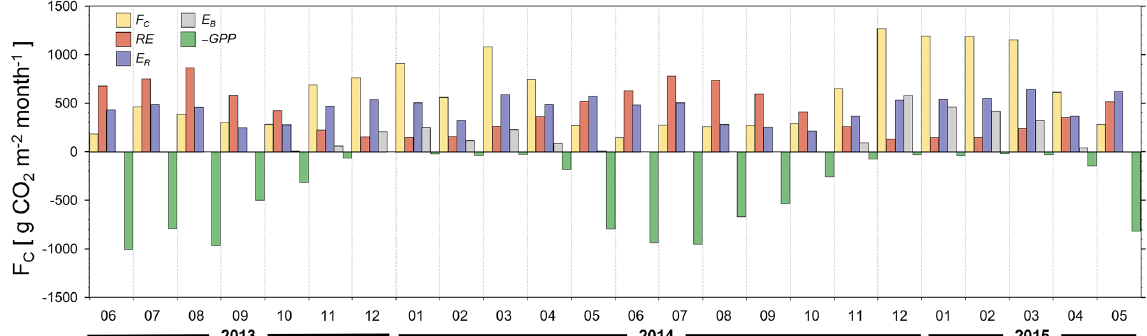
Figure 13. Monthly sums for gap-filled F C (yellow bar) with RE (red bar), E R (blue bar), E B (gray bar), and − GPP (green bar).